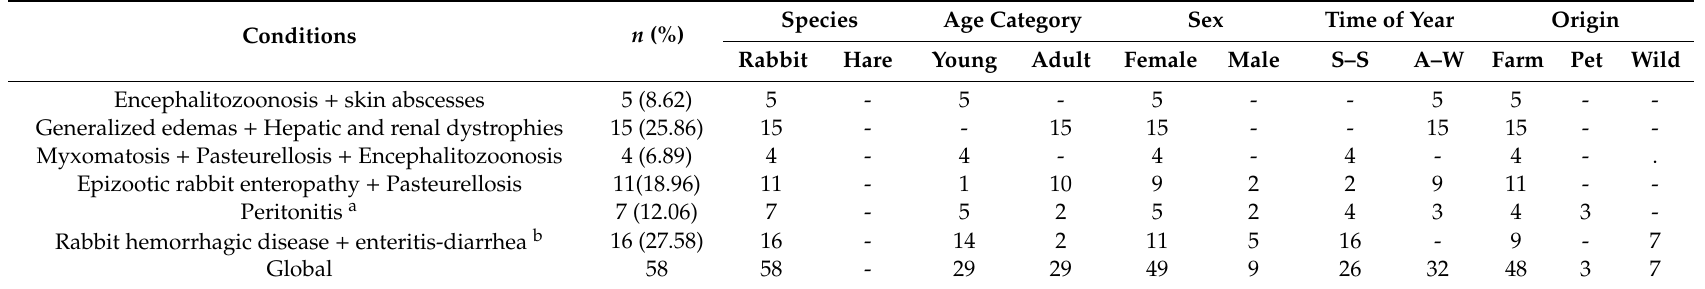
Table 3. Distribution of the number of cases in which more than one disease / condition was diagnosed in lagomorphs referred to Department of Animal Health (Faculty of Veterinary Science, University of Le ó n, Spain) during